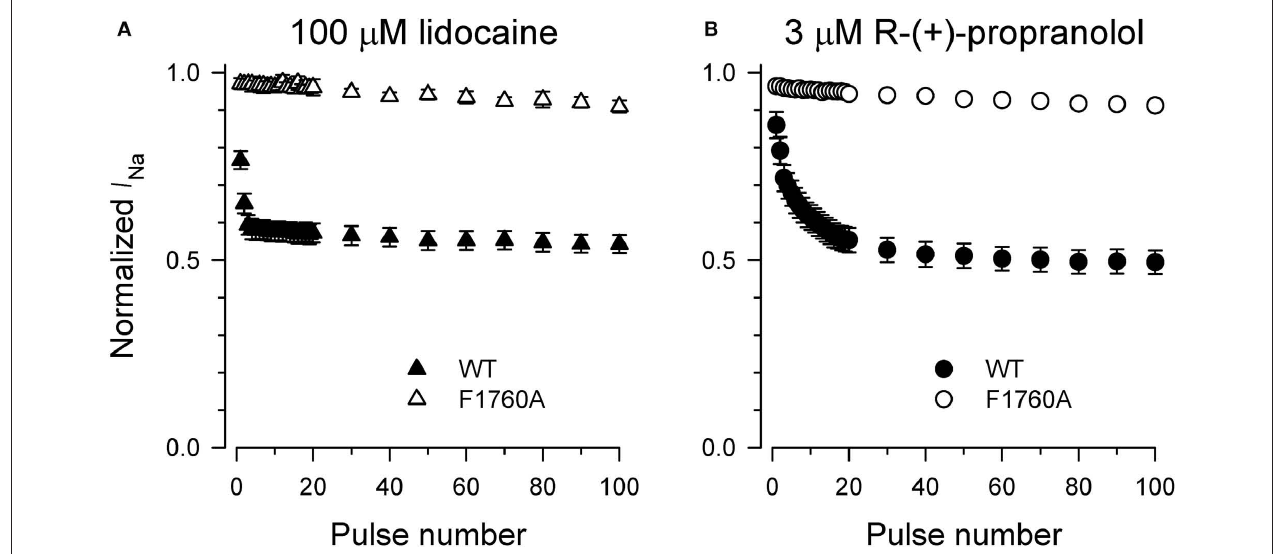
Figure 5 | Phenylalanine-1760 is required for Na 1.5 block by propranolol. Steady-state use-dependent inhibition of WT-Na V lidocaine (A) and 3 μM R-( + )-propranolol (B) during 1 Hz pulsing to − 10 mV from a holding potential of − 120 mV. Each point represents mean ± SEM from 7 to 14